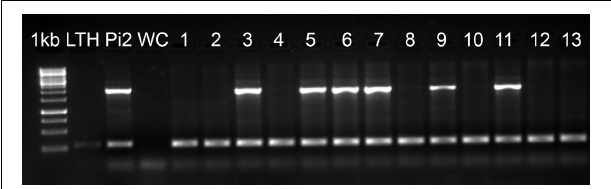
FIGURE 5 | Molecular screening of UBN resistant genotypes for Pi2 locus. Molecular screening of 3176 UBN-resistant rice genotypes revealed 794 genotypes carrying the Pi2 locus. 1kb, DNA marker; LTH, negative control; Pi2 , positive control ( Pi2 -monogenic line); WC, water control; 1–13, test accessions. The accessions positive for Pi2 are 3 (IRGC 254), 5 (IRGC 257), 6 (IRGC 258), 7 (IRGC 840), 9 (IRGC 846), and 11 (IRGC 877). The upper band ( ∼ 2kb) indicates the presence of Pi2 locus and the lower band ( ∼ 250 bp) shows the actin band, which is an internal control for the